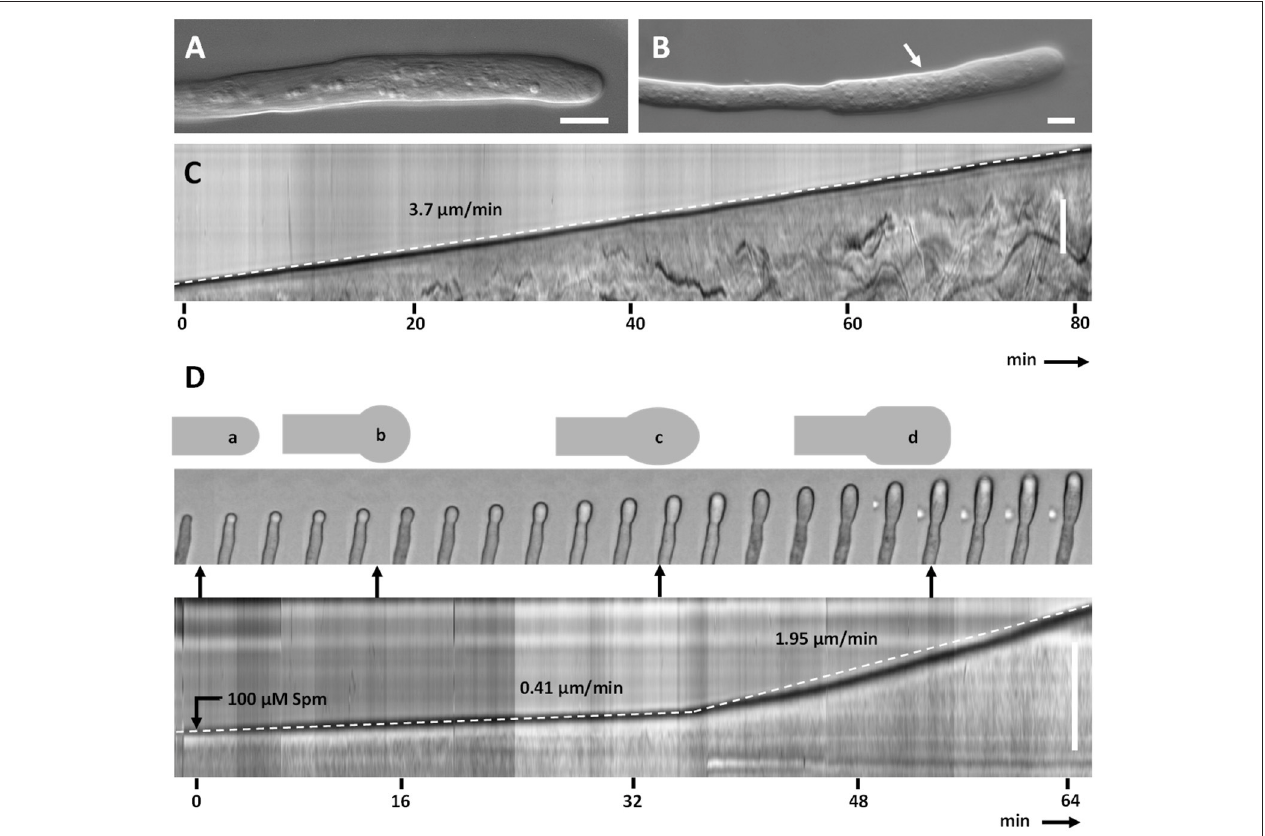
FIGURE 2 | Kymograph analysis of pear pollen tubes after Spm treatment. (A) DIC view of a control pollen tube. (B) A typical enlarged pollen tube after Spm treatment. Bars: 20 µ m. (C) Control pollen tube analyzed by kymograph. The dotted line indicates the linearity of growth. The X-axis is the time in minutes, while the Y-axis is the distance covered by the tube tip (scale bar for Y-axis is 100 µ m). (D) (top part) Video frames showing the effects induced by Spm on a pollen tube. Cartoons indicate the main morphological stages that characterize pollen tubes after Spm treatment; (a) no Spm; (b) balloon shape; (c) snake shape; (d) shovel shape (bottom part). Kymograph analysis of a Spm-treated pollen tube. Spm was added at time zero. Scale bar for Y-axis is 500 µ m. Small black arrows connecting the kymograph with video frames indicate approximately the time characterized by the four pollen tube shapes. Data are representative of six independent